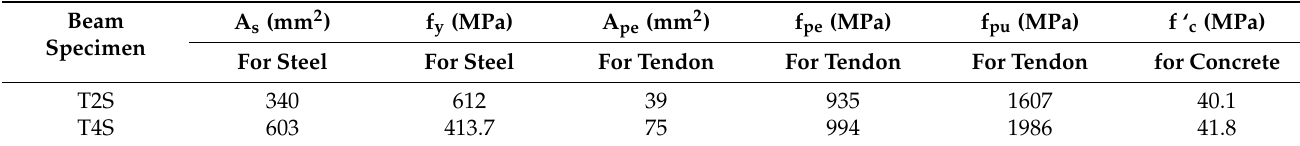
Table 1. Summary of parameters of beam specimens [19].